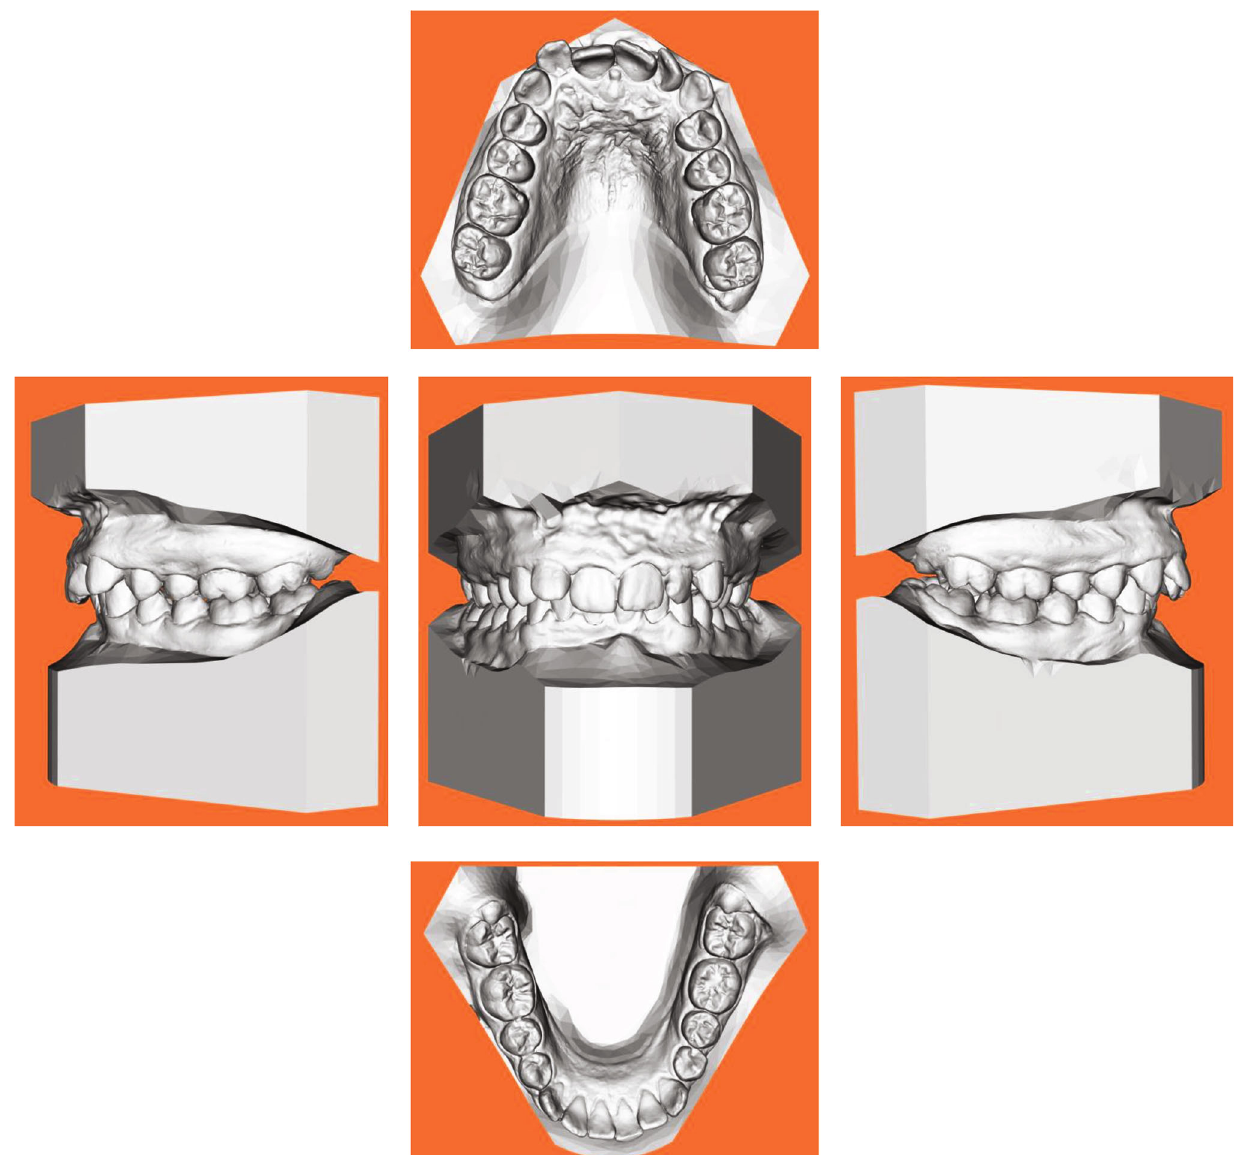
Figure 5: Initial digital model.